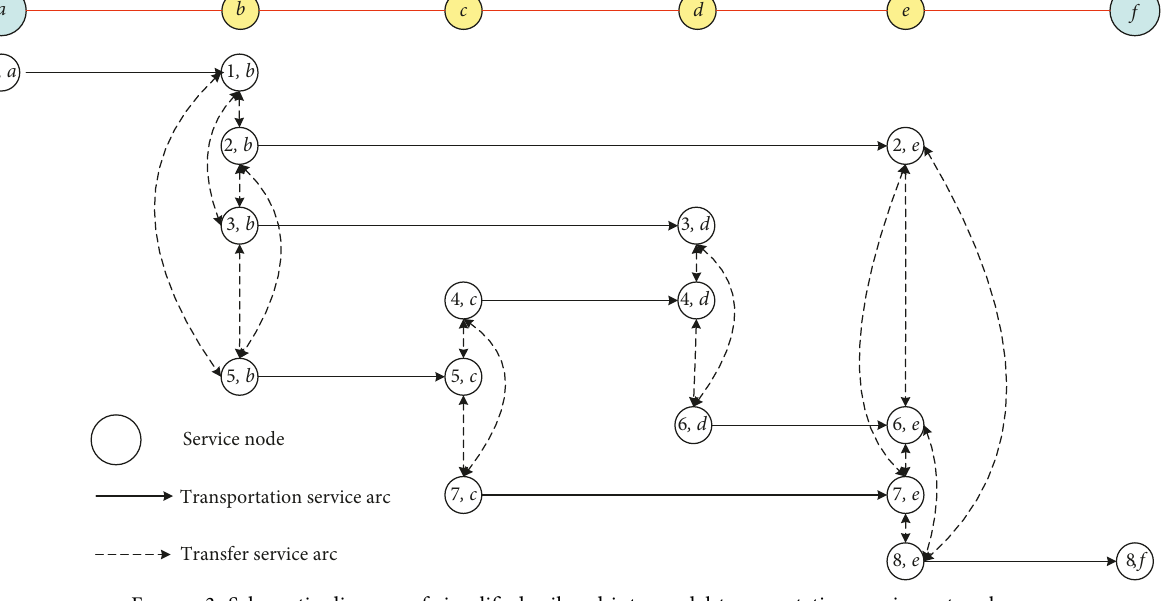
Figure 3: Schematic diagram of simplified railroad intermodal transportation service